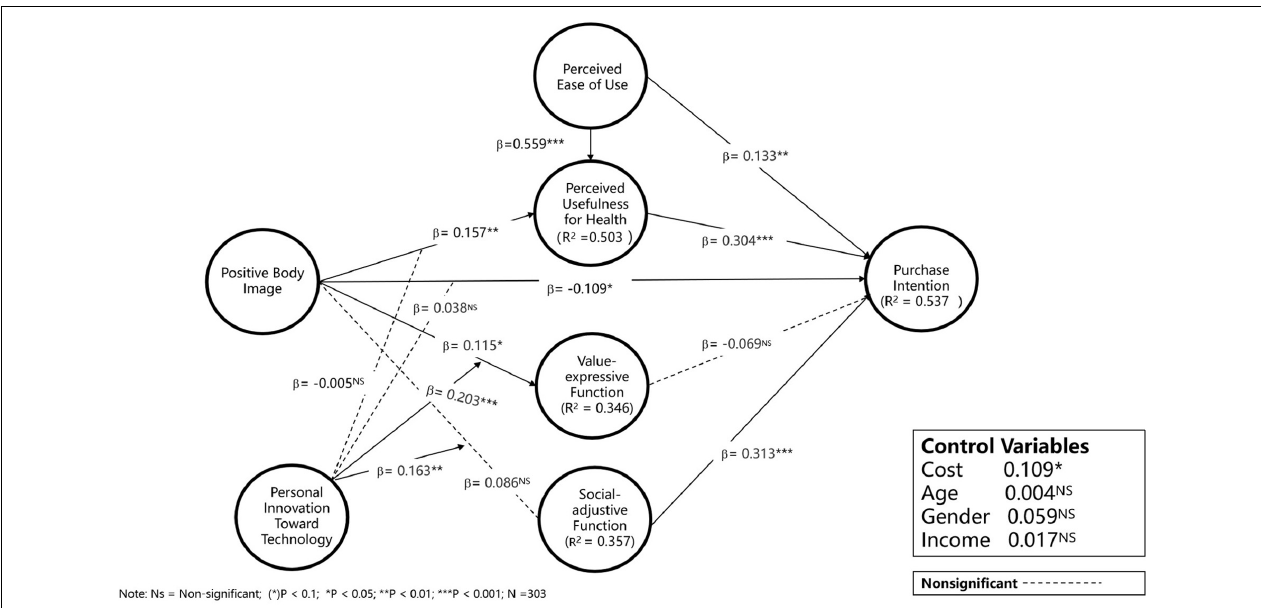
FIGURE 2 | PLS regression results for the models with moderation.